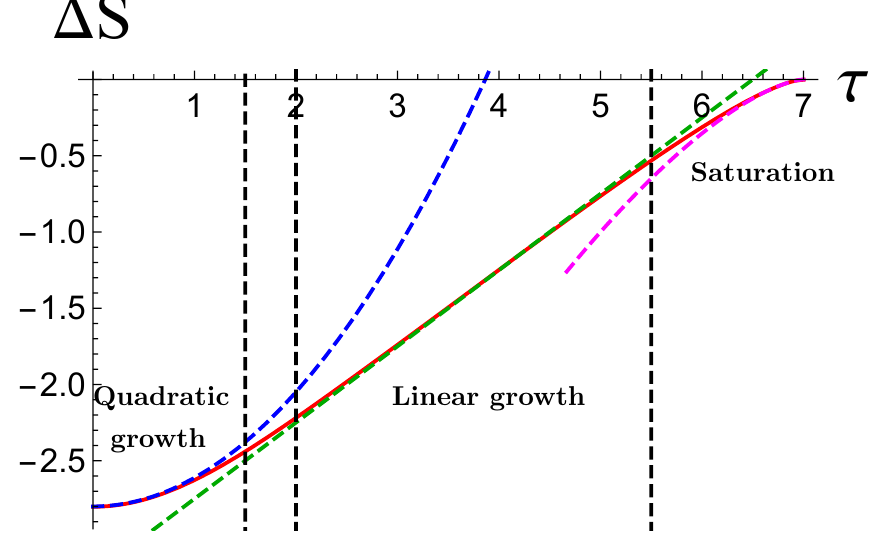
Figure 4 . Typical time dependence of (cid:1) S ( ‘; (cid:28) ) for some (cid:12)xed ‘ and z H (here ‘ = 7 and z H = 2). The red curve is the entanglement entropy dependence (cid:1) S ( ‘; (cid:28) ), the blue curve is the quadratic approximation to initial growth (3.3), the green line is the linear growth regime (3.18) and magenta line corresponds to the asymptotic describing saturation regime